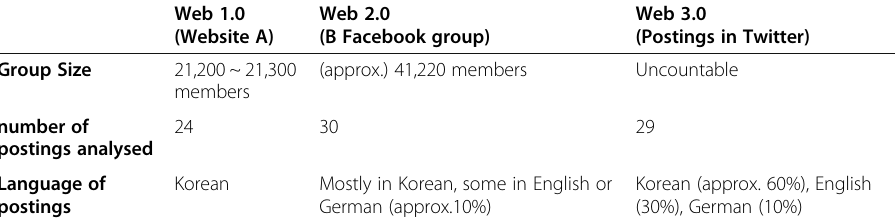
Table 2 Data sources and main features of the discussions on each generation of Online Social